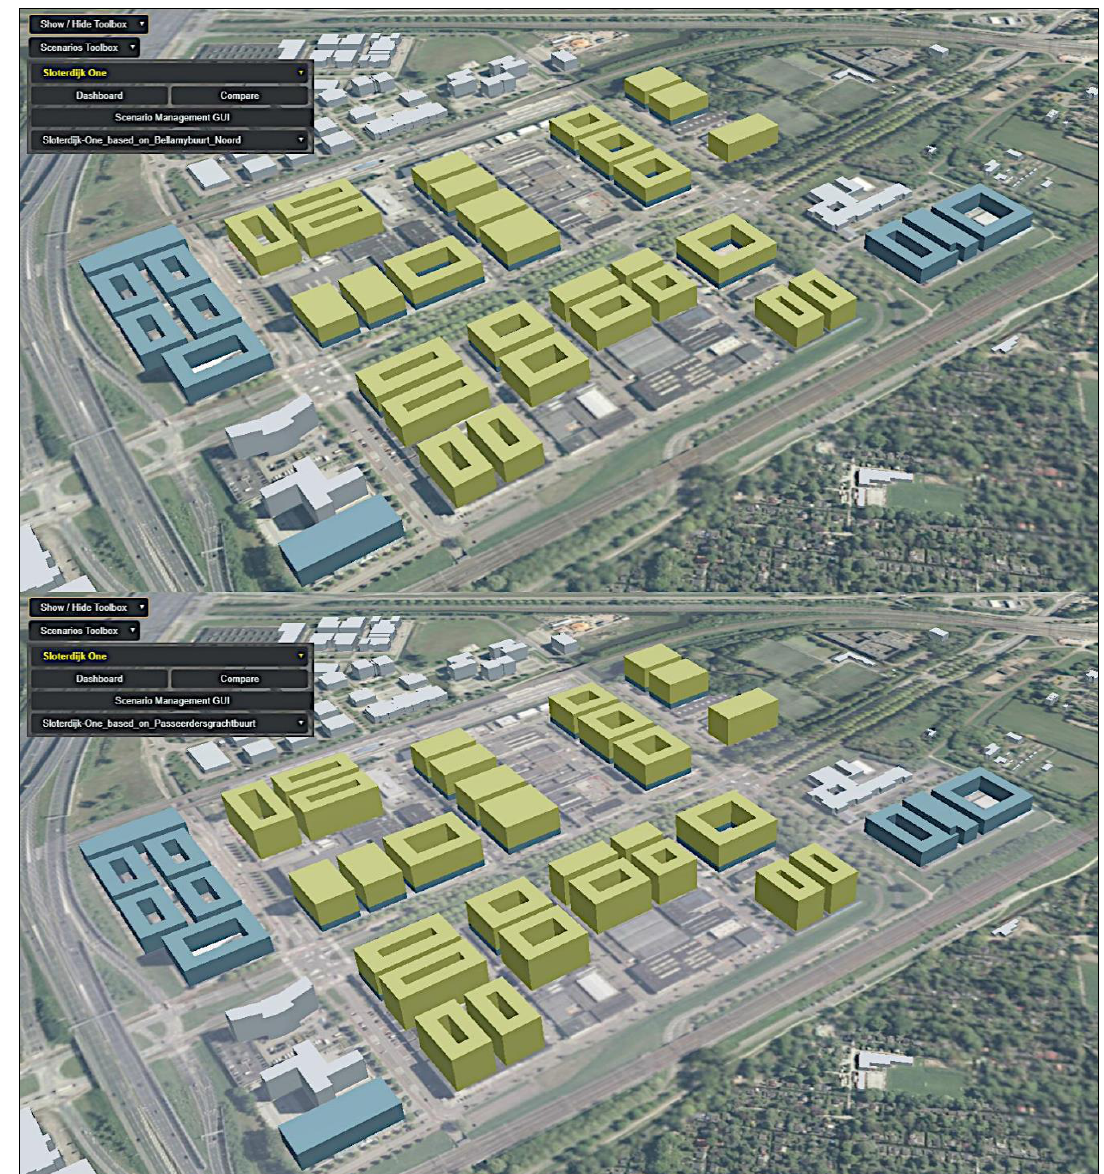
Figure 27. ( Top ) Scenario of “Sloterdijk One” based on Bellamybuurt Noord and ( bottom ) based on Passeerdersgrachtbuurt.